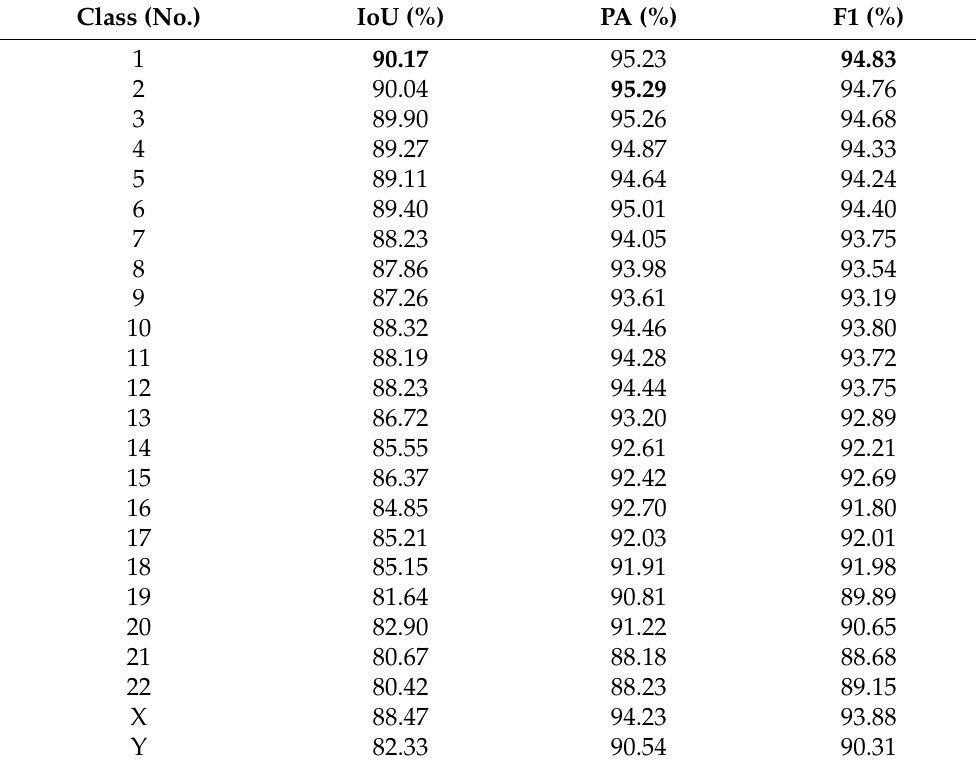
Table 2. Segmentation performance of ChroSegNet for various chromosome instances. Class